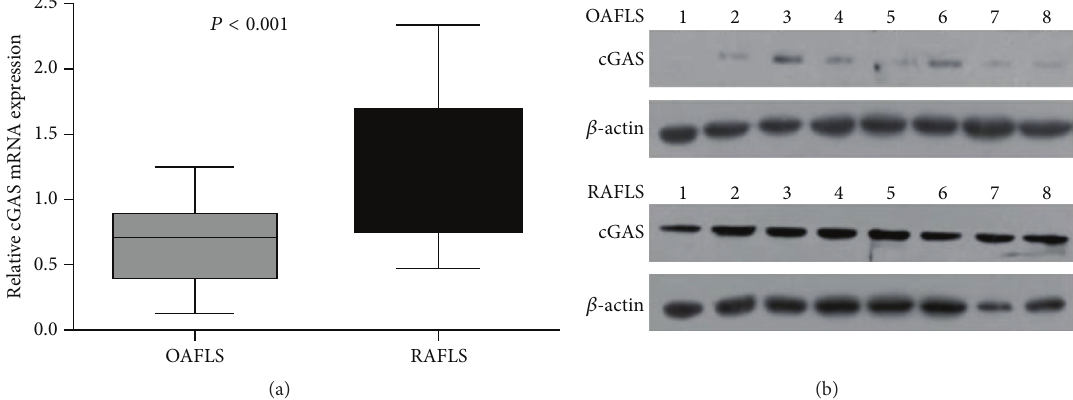
Figure 1: Expression of cGAS is enhanced in RA-FLS compared with OA FLS. (a) qRT-PCR analysis of cGAS expression in 8 RA-FLS and 8 OA FLS. Quantitative analysis of cGAS expression was normalized to 𝛽 -actin expression. (b) Western blotting identified the expression of cGAS in RA-FLS and OA